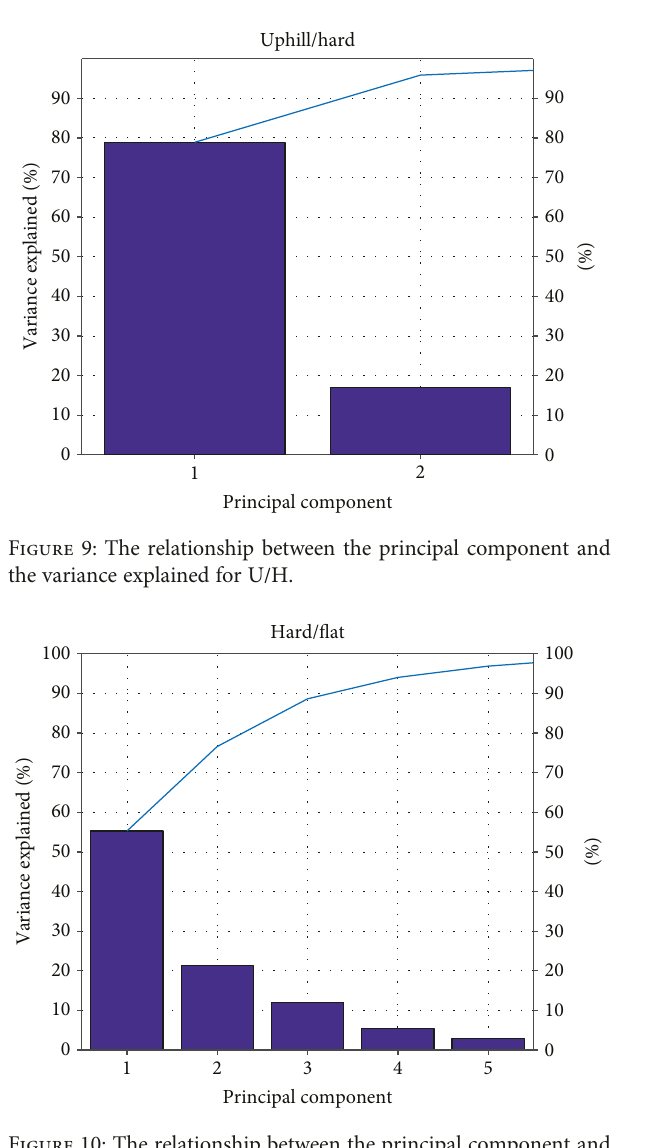
Figure 10: The relationship between the principal component and the variance explained for H/F.